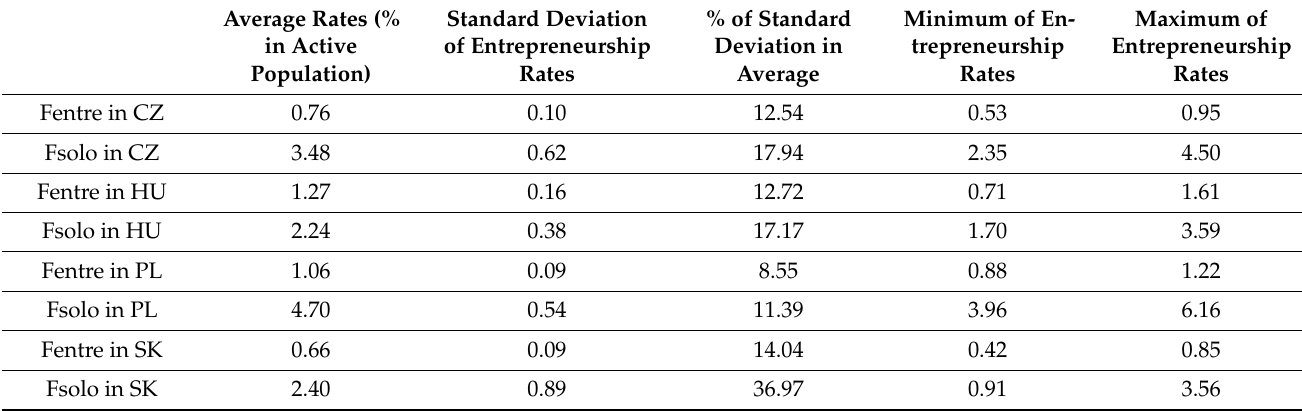
Table 2. Descriptive statistics of female entrepreneurship rates in the active population, in the Visegrad countries, in